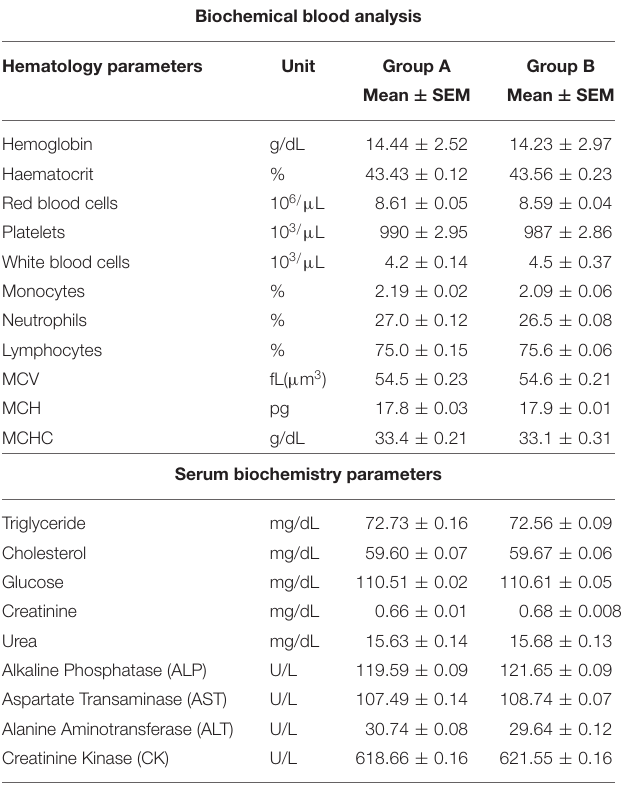
TABLE 5 | Biochemical parameters of control and hydrogel treated rats for acute oral toxicity study. Biochemical blood analysis